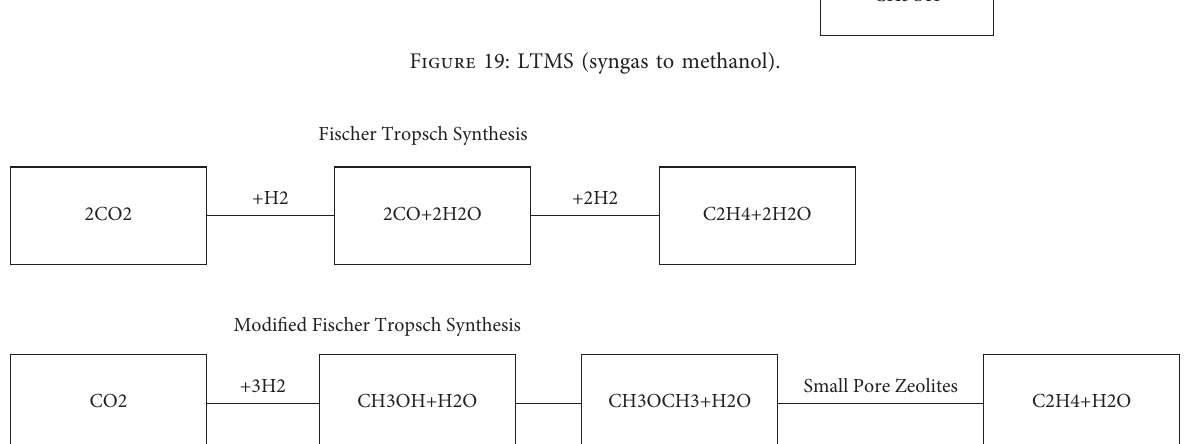
Figure 19: LTMS (syngas to methanol).